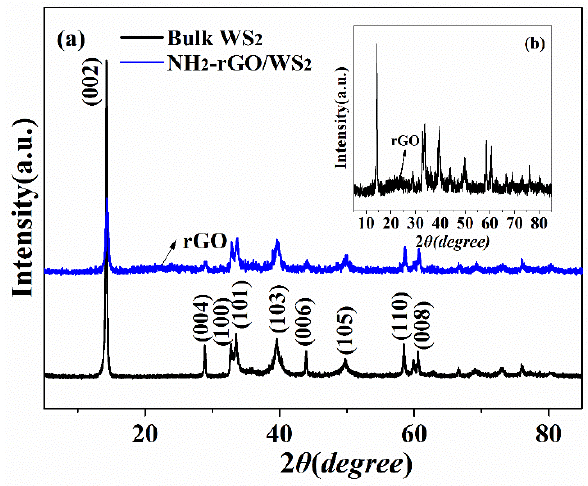
Figure 2. XRD patterns of bulk WS 2 and NH 2 -rGO/WS 2 nanosheets.